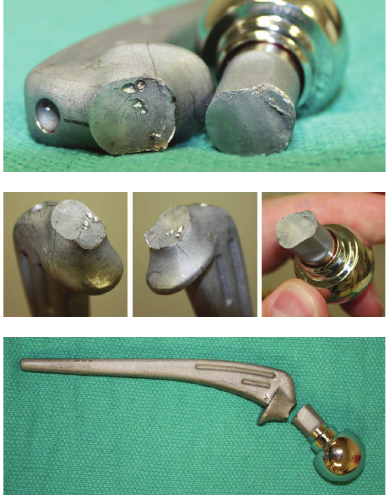
Figure 3: Implant examination from different perspectives shows no gross mechanical or chemical degradation at the fracture